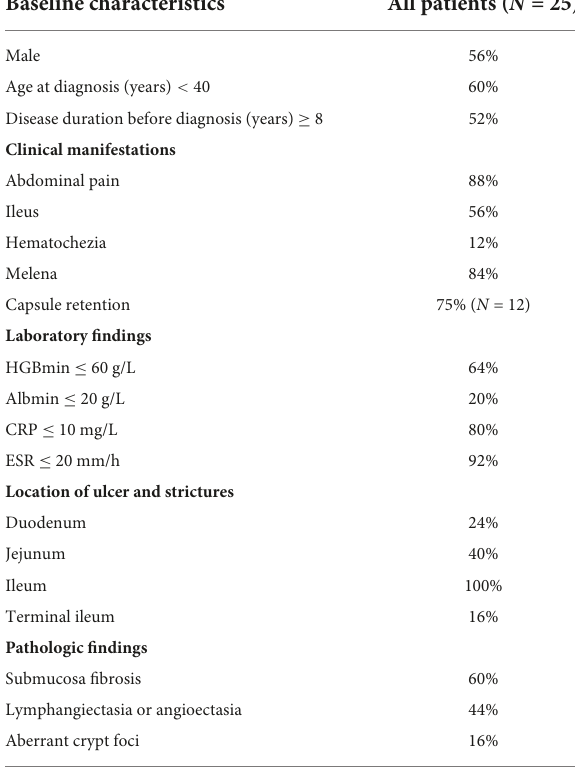
TABLE 1 Baseline and clinical characteristics of patients with